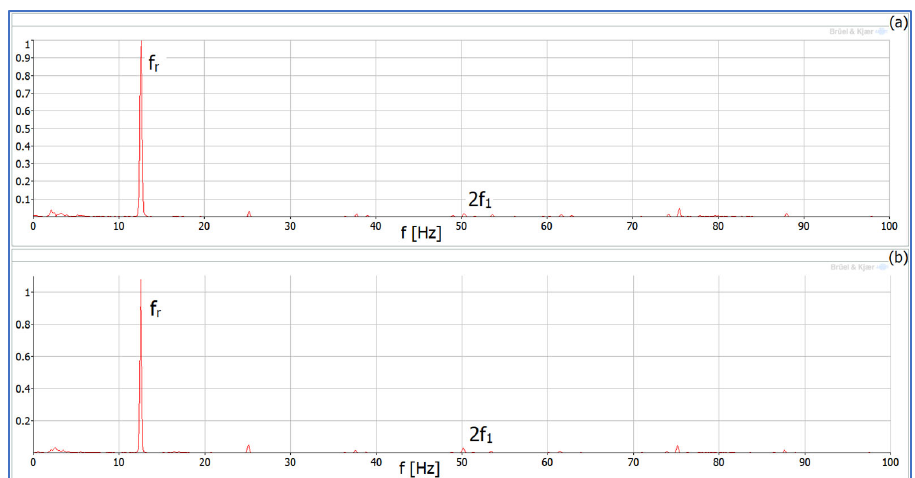
Figure 17. Vibration spectral characteristics for a rotational speed of 750 rpm and no load, where ( a ) characteristics—1h supply, ( b ) characteristics—1h and 3h supply.